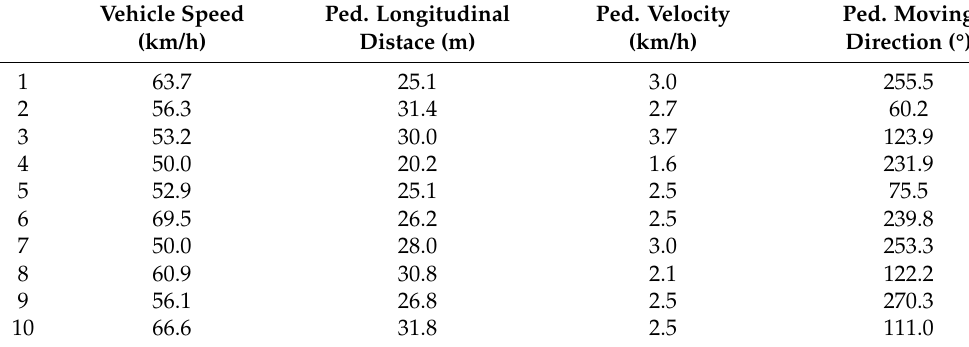
Table 2. Init parameters of the